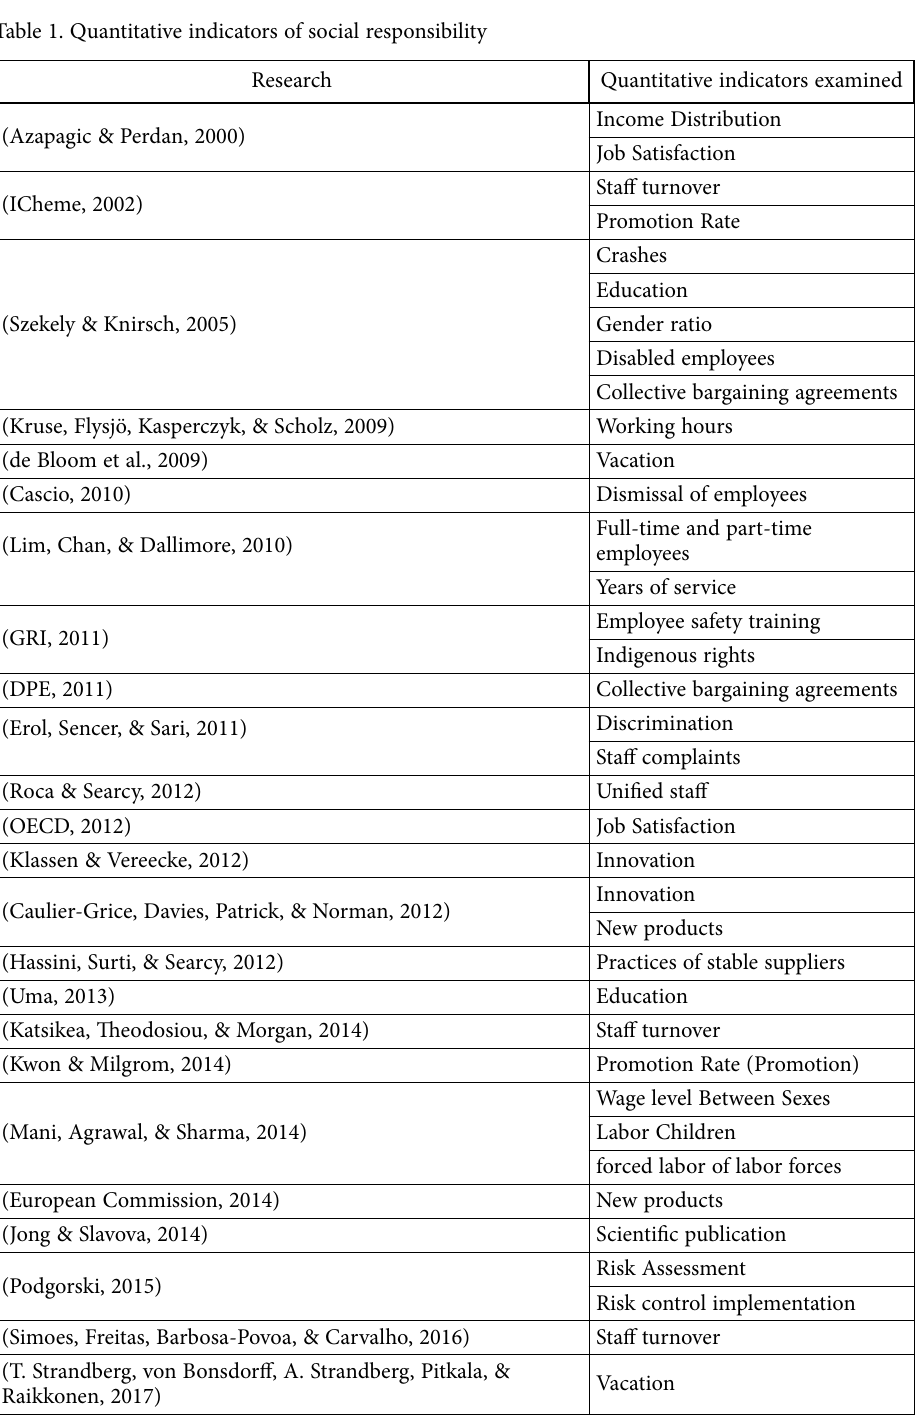
Table 1. Quantitative indicators of social responsibility